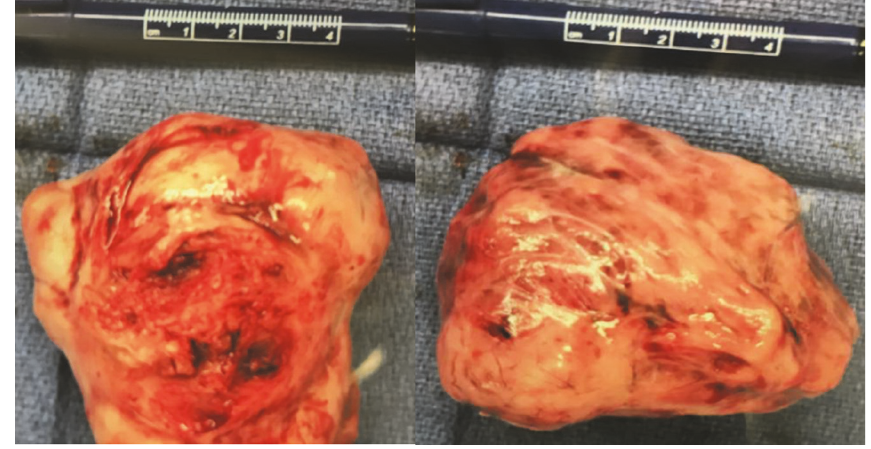
Figure 2: Two images of the 6 cm x 8 cm avulsed uterine leiomyoma recovered from the patient during laparotomy.